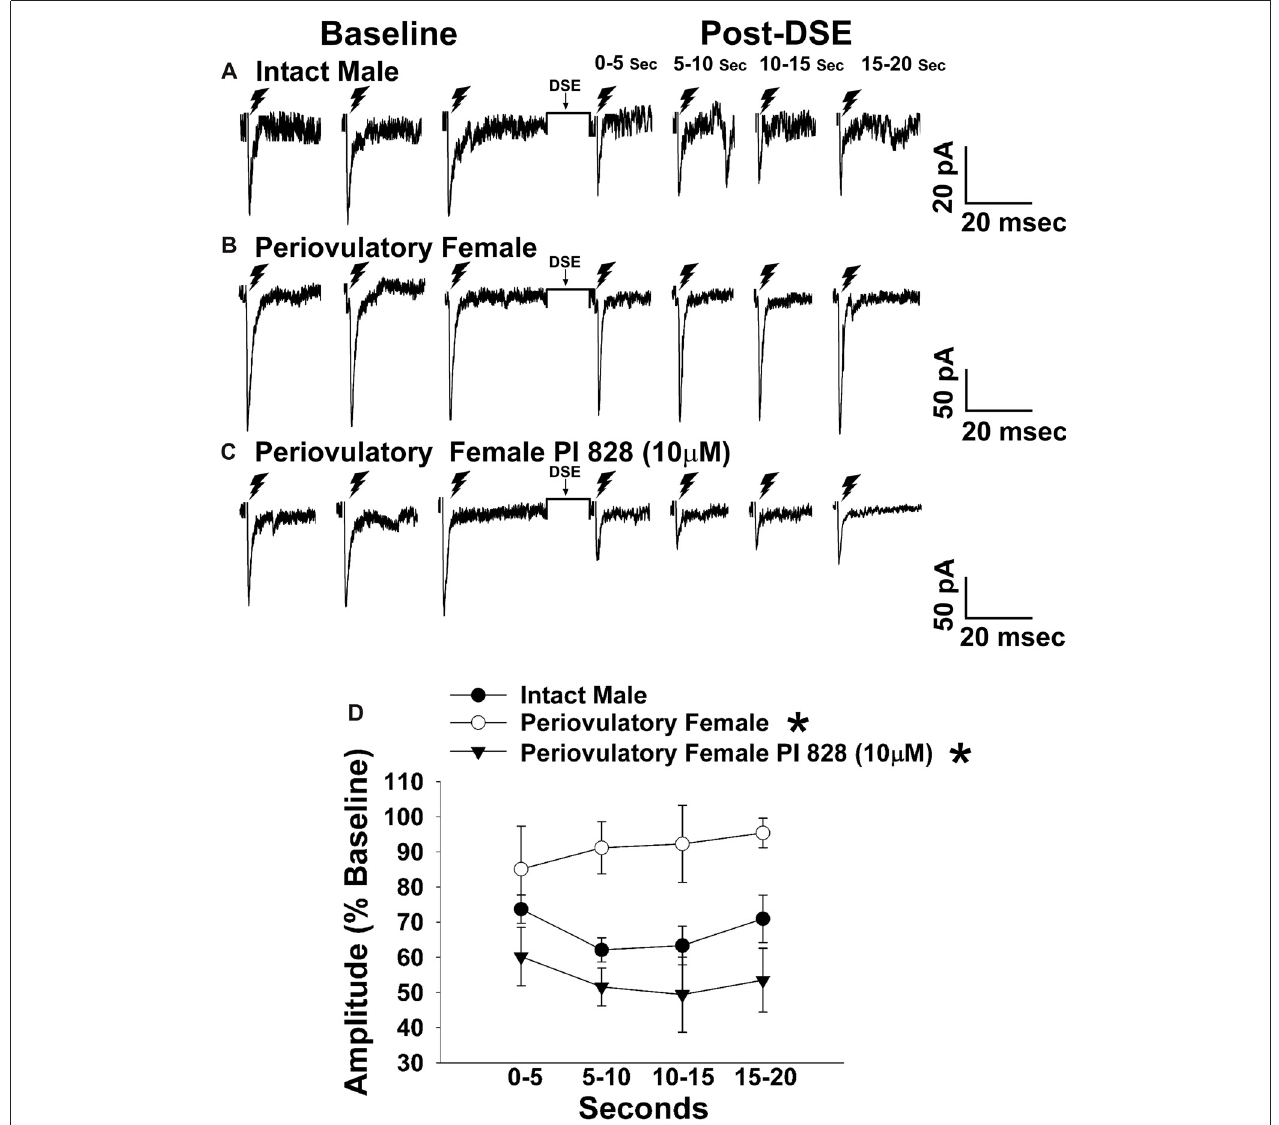
FIGURE 3 | The postsynaptic depolarization-induced reduction in excitatory input onto proopiomelanocortin (POMC) neurons generated by stimulation of the dorsomedial ventromedial nucleus (VMN) is larger in males than in periovulatory females, which is reversed by the phosphatidylinositol-3-kinase (PI3K) inhibitor